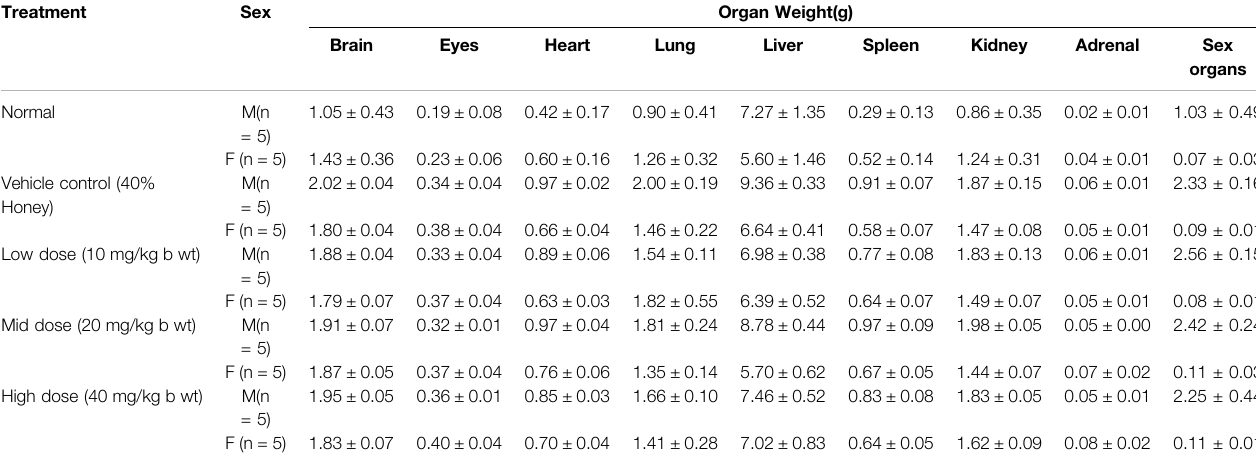
TABLE 8 | Effect of in-house Thamira parpam on Organ weight. Treatment Sex